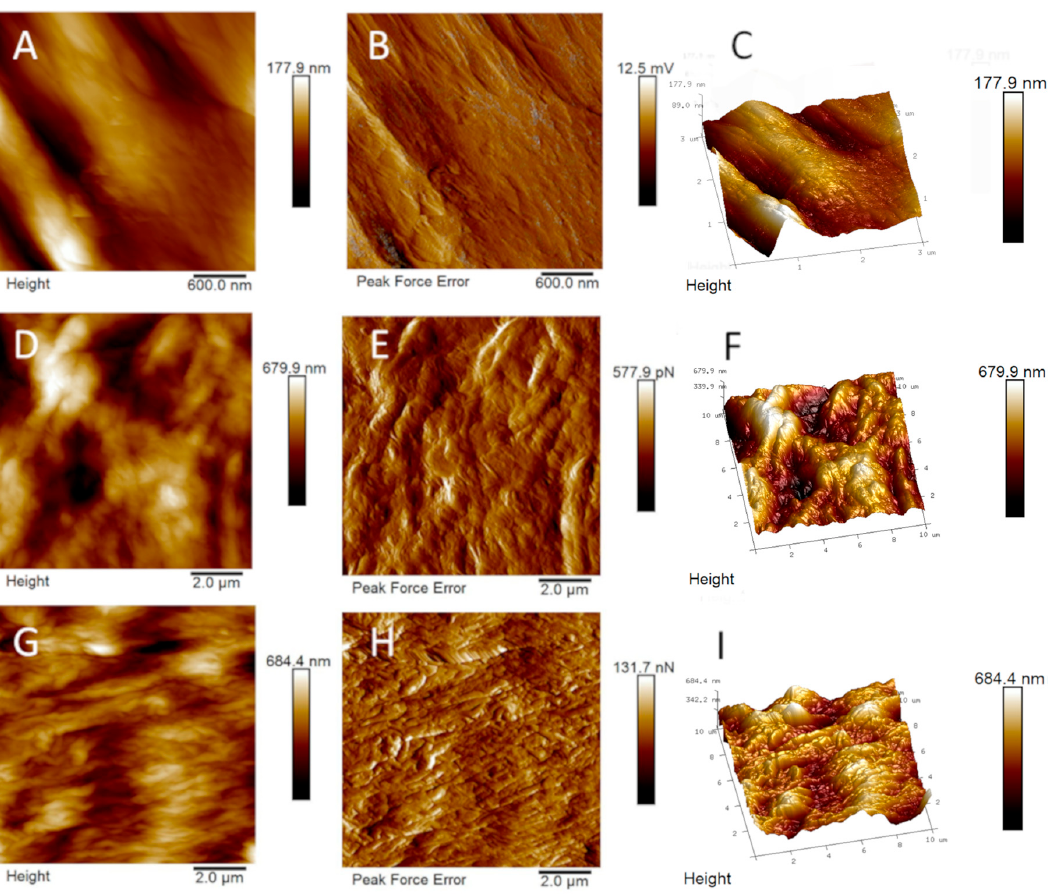
Figure 3. ( A , D , G ) Topographical, ( B , E , H ) Peak force error and ( C , F , I ) Three-dimensional Atomic Force Figure 3. ( A,D,G ) Topographical, ( B,E,H ) Peak force error and ( C,F,I ) Three-dimensional Atomic Miscroscopy (AFM) images of bare Lamina (upper line), Lamina enriched with 5 µ g / mL of GO (central Force Miscroscopy (AFM) images of bare Lamina (upper line), Lamina enriched with 5 µg/mL of GO line) and Lamina enriched with 10 µ g / mL GO (bottom (central line) and Lamina enriched with 10 µg/mL GO (bottom line).